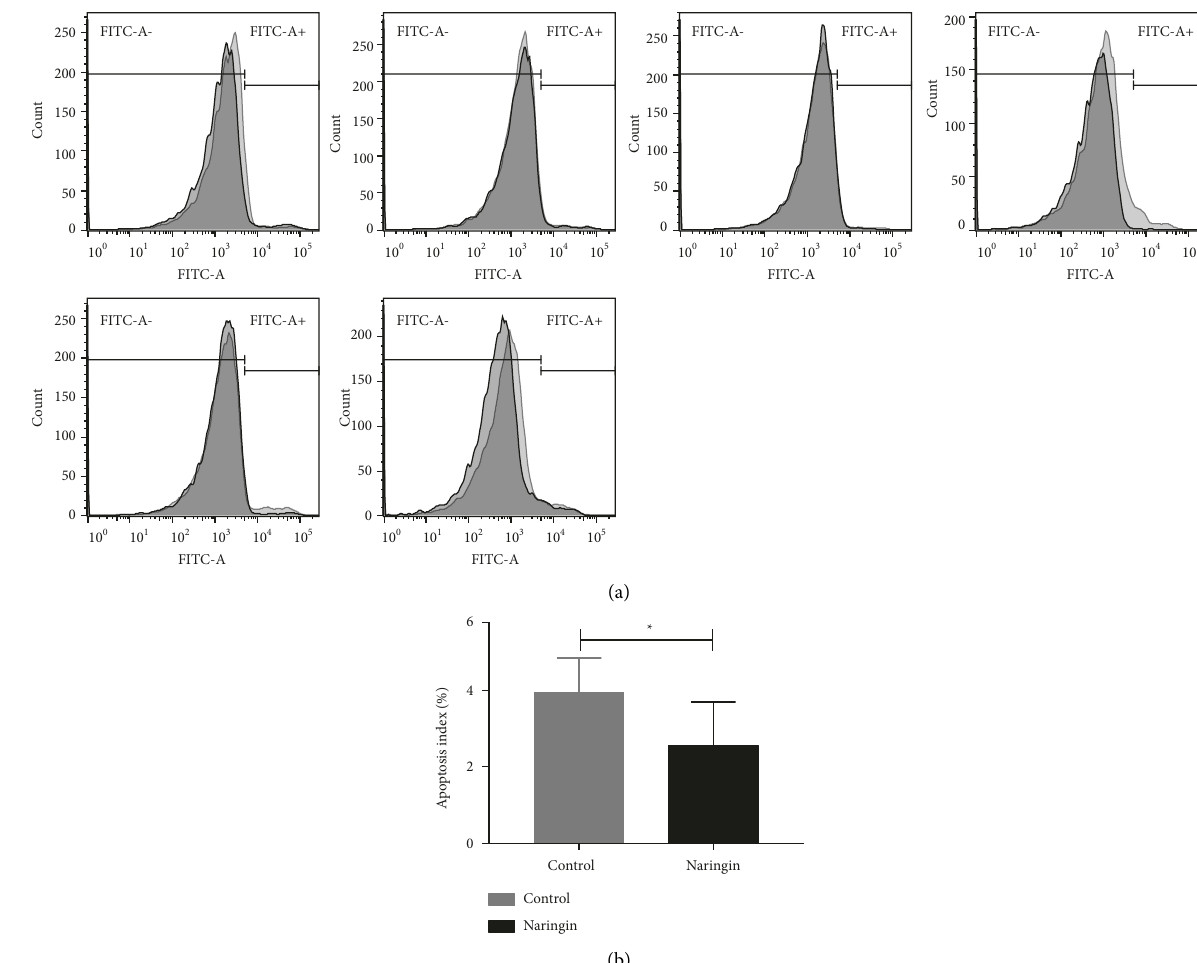
Figure 5: (a) Flow cytometry histograms of apoptosis assays in packed RBCs. The RBCs were stored at 4 ° C for 35 days with naringin solution or equal volume of PBS. (b) Apoptosis of packed RBCs at 35 days. ∗ signifies p < 0 . 05 vs control